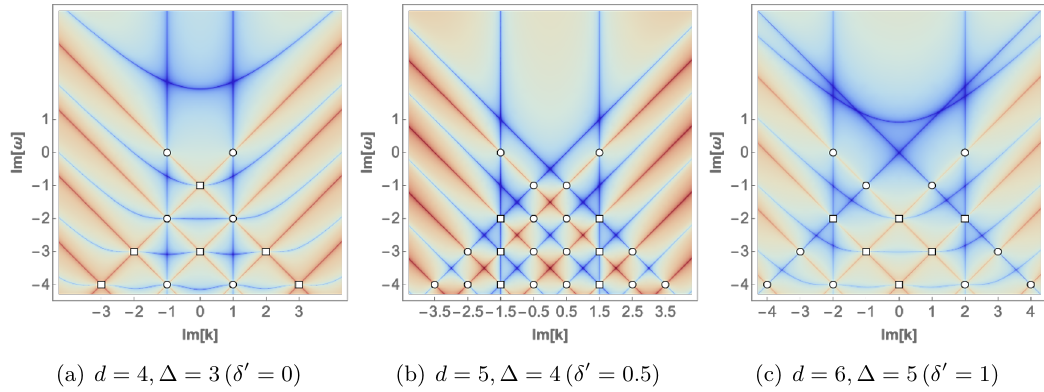
(Im[ ω ] , Im[ k ]) | at d = 4 , 5 , 6 . The blue lines and red lines represent zeros Figure 4 . log |G ∆= d − 1 V and poles of the Green’s function respectively. The white circles and squares are type I and type II pole-skipping points, respectively. The meaning of type I and II will be explained in section